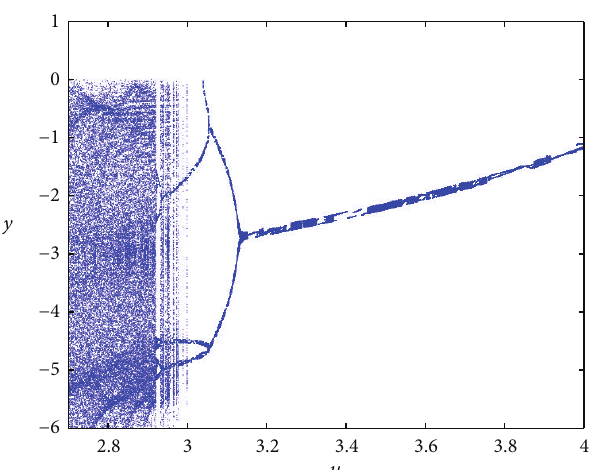
Figure 12: Bifurcation diagram of system (2) versus 𝑢